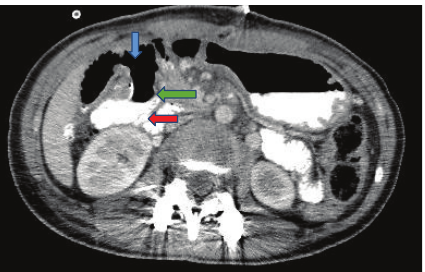
Figure 4: Oral contrast passing from the duodenum (red arrow) to the jejunum (blue arrow) and the patent duodenojejunal anastomo- sis (green